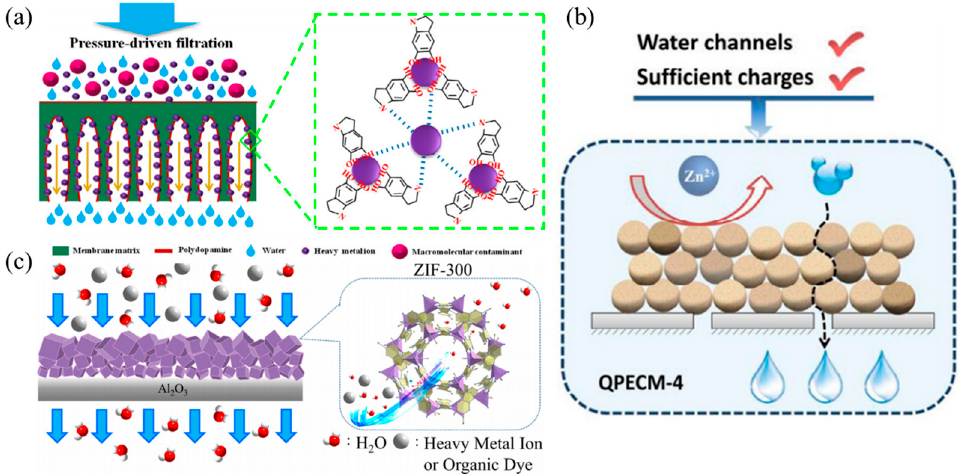
Figure 4. HM removal via ( a ) adsorptive membrane technique. Adapted from [56], with permission from Elsevier, 2017. ( b ) surface-charged modified membrane repellent. Adapted from [57], with permission from Elsevier, 2019. and ( c ) size exclusion of HM ions. Adapted from [58], with permission from Elsevier, 2019.